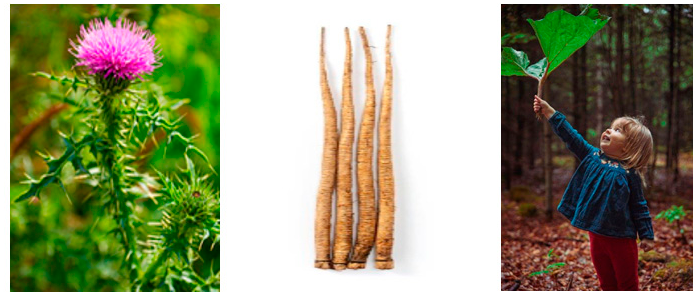
Figure 4. Arctium lappa plant, roots, and leaves.